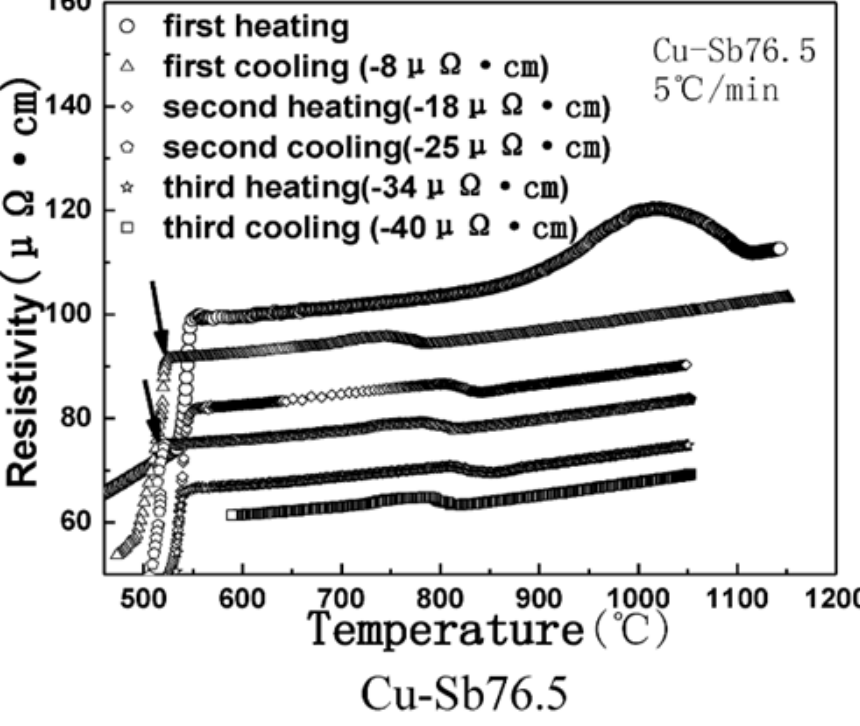
Figure 9. Resistivity falls of Cu-Sb 76.5 wt% after thermal cycling. Reproduced from